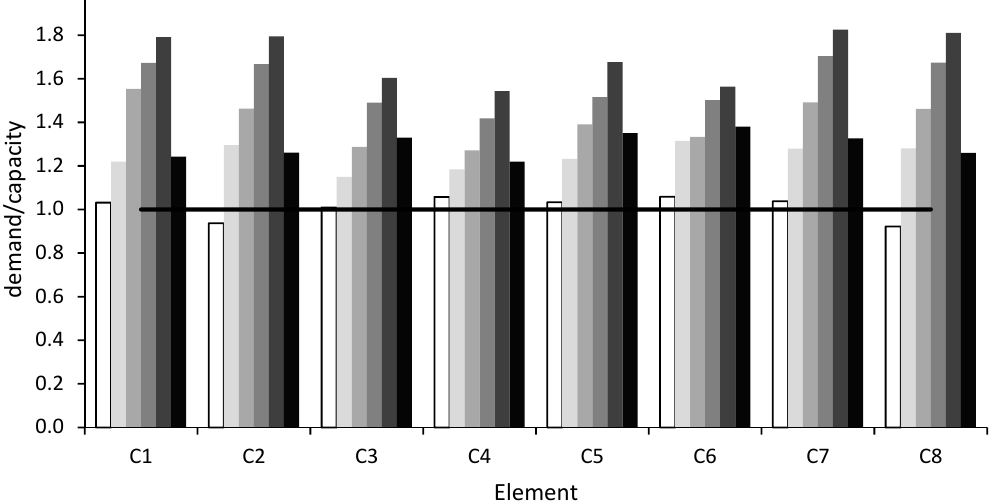
Figure 15. Combined bending and compression verifications of columns in as-built conditions.